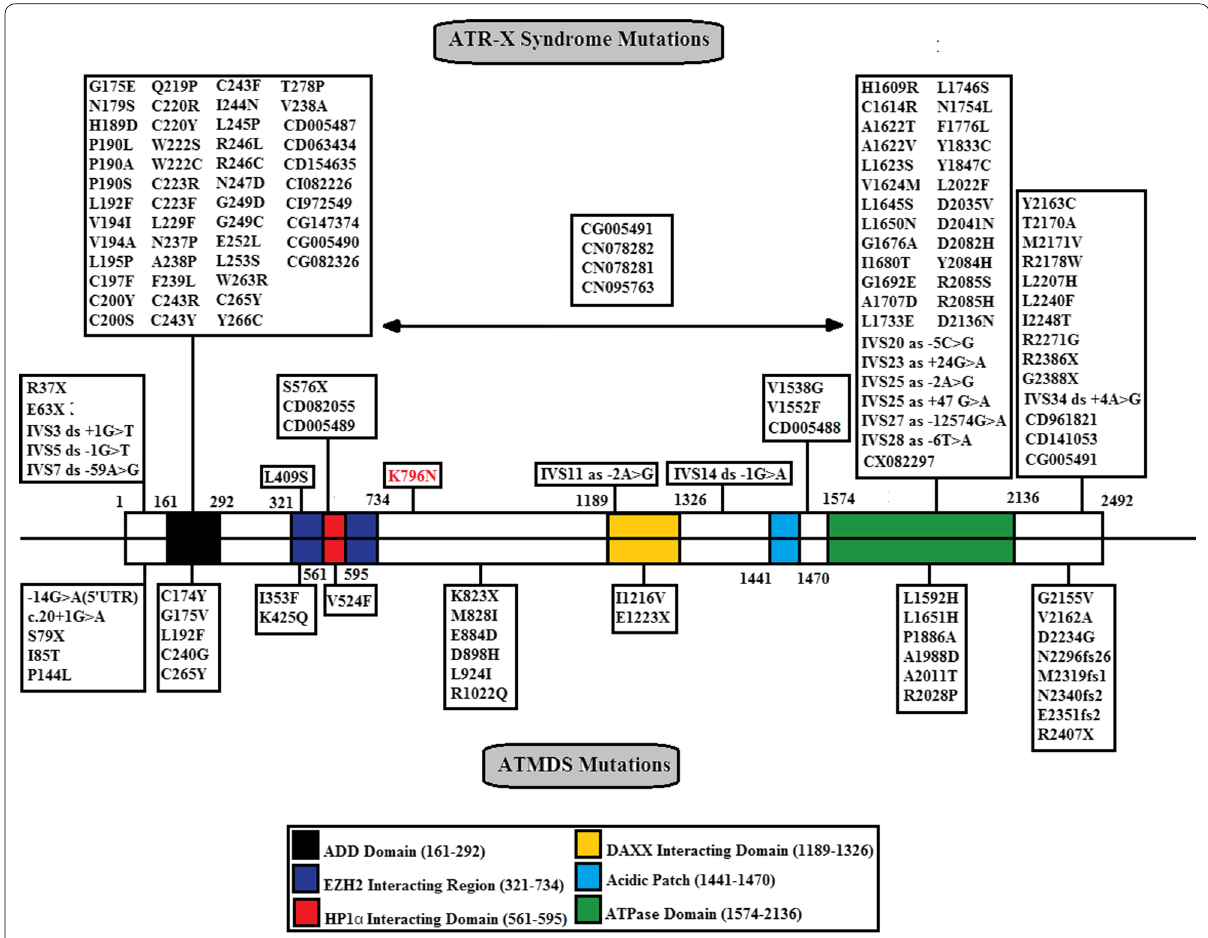
Fig. 2 The diagram of ATRX protein and the distribution of mutations previously reported in its 6 domains. The mutation found in the current study is shown with red